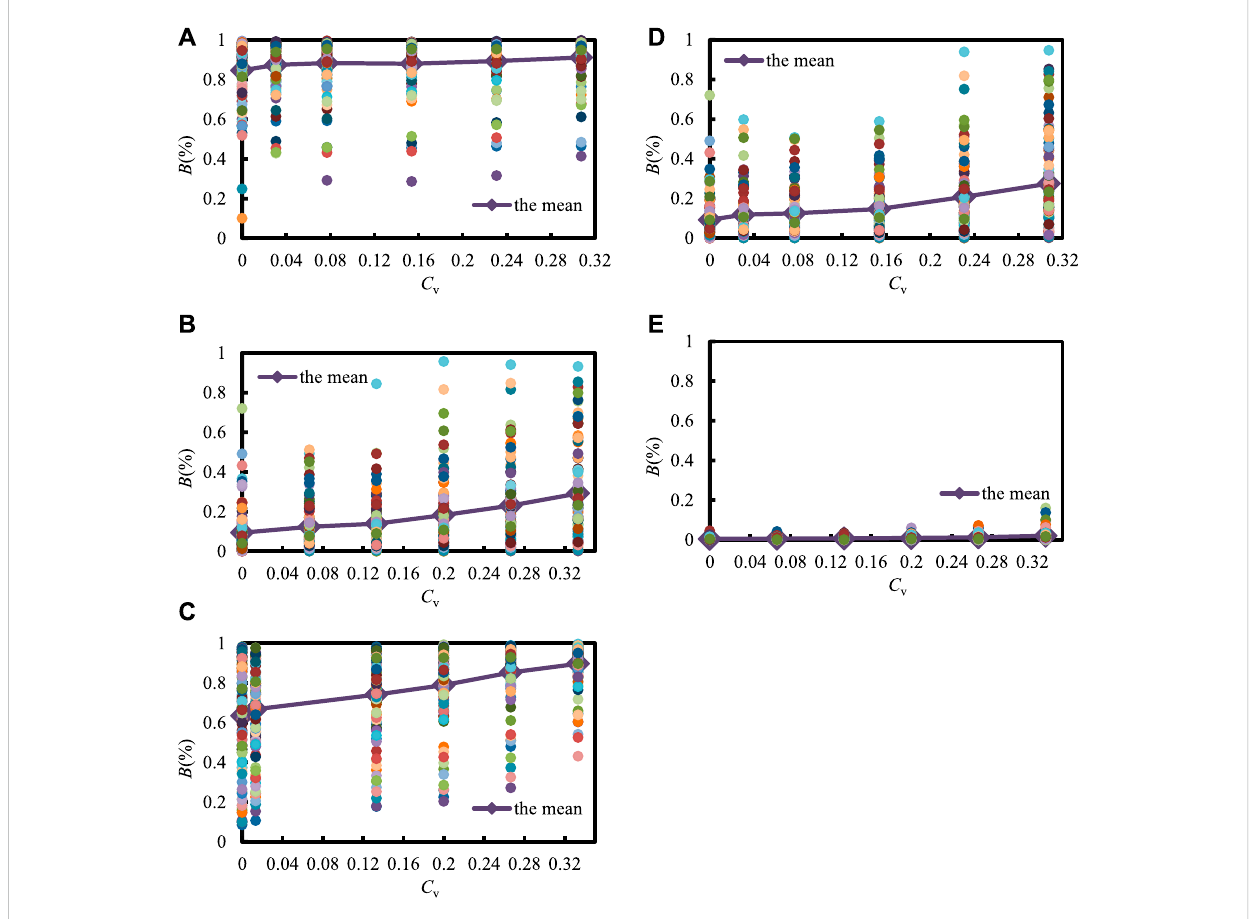
The relationships between B and the dispersion of fracture size ( C v ): (A – E) is model I – V, the domain size of model I to Ⅴ is 4 m 3 × 4 m 3 × 4 m 3 , 3.6 m 3 × 3.6 m 3 × 3.6 m 3 , 18.2 m 3 × 18.2 m 3 × 18.2 m 3 , 7.8 m 3 × 7.8 m 3 × 7.8 m 3 , 2.6 × 2.6 × 2.6 m 3 .